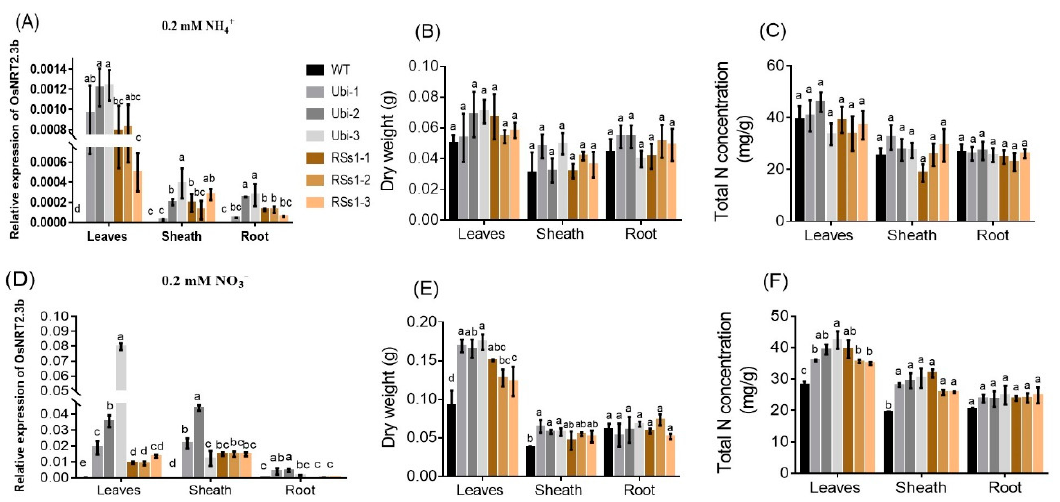
Figure 7. The e ff ect of di ff erent N supplies on the expression of OsNRT2.3b , plant dry weight, and total N concentration in di ff erent plant parts in hydroponic experiment. ( A – C ) 0.2 mM NH 4 + treatment, ( A ) the relative expression of OsNRT2.3b ; ( B ) the dry weight; ( C ) the total N concentration of di ff erent parts in all barley lines. ( D – F ) Under 0.2 mM NO 3 − treatment, ( D ) relative expression of OsNRT2.3b ; ( E ) the dry weight; ( F ) the total nitrogen concentration of di ff erent parts in all barley lines. Error bars: standard error ( n = 4 plants). Significant di ff erences between transgenic and WT lines are indicated by di ff erent letters ( p < 0.05, one-way ANOVA).